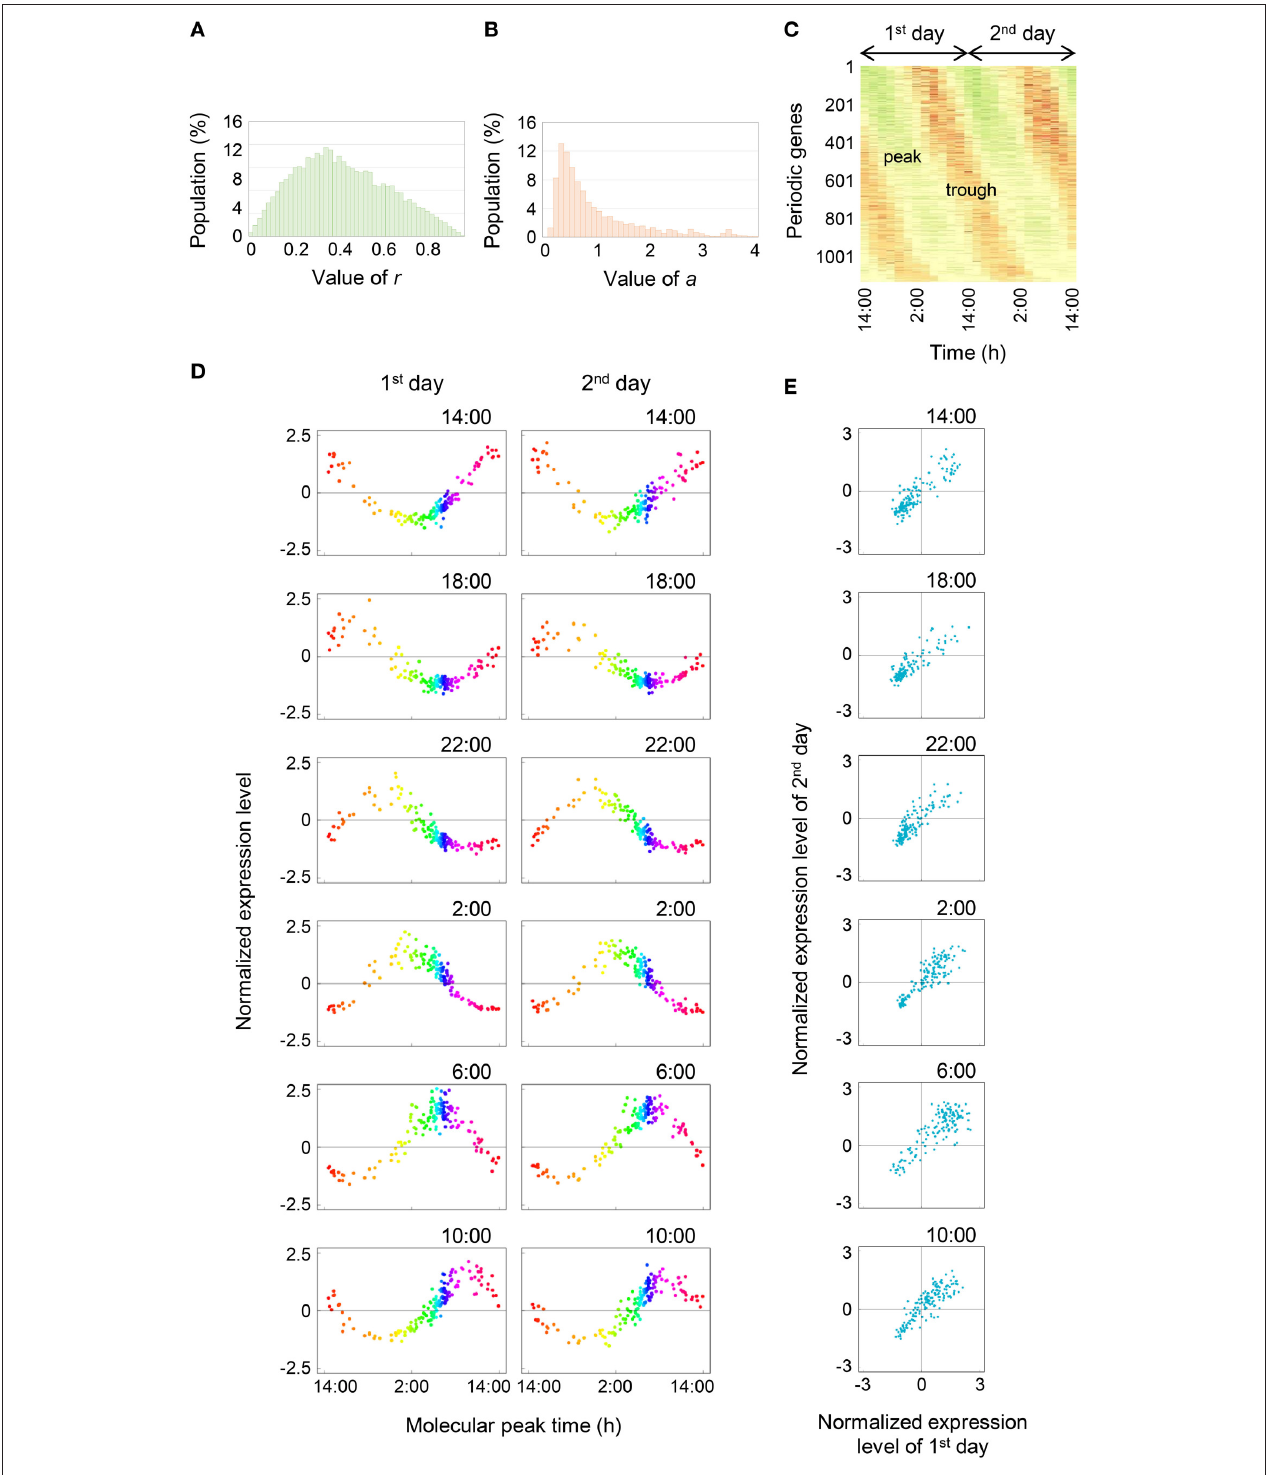
FIGURE 2 | Comprehensive analysis of diurnal oscillation in gene expressions. (A,B) Histograms of the r and a values, respectively. (C) Oscillation behavior of time-indicating genes. Green area indicates the peak and red area indicates the trough. (D) Expression profiles of 143 time-indicating genes for the 1st and 2nd days. The time at the top right of the plot area indicates the sampling time. The range from orange to purple represents night-time and other colored areas represent day-time. (E) Correlations between normalized expression levels for the 1st and 2nd days. The time at the top right of the plot area indicates the sampling time.